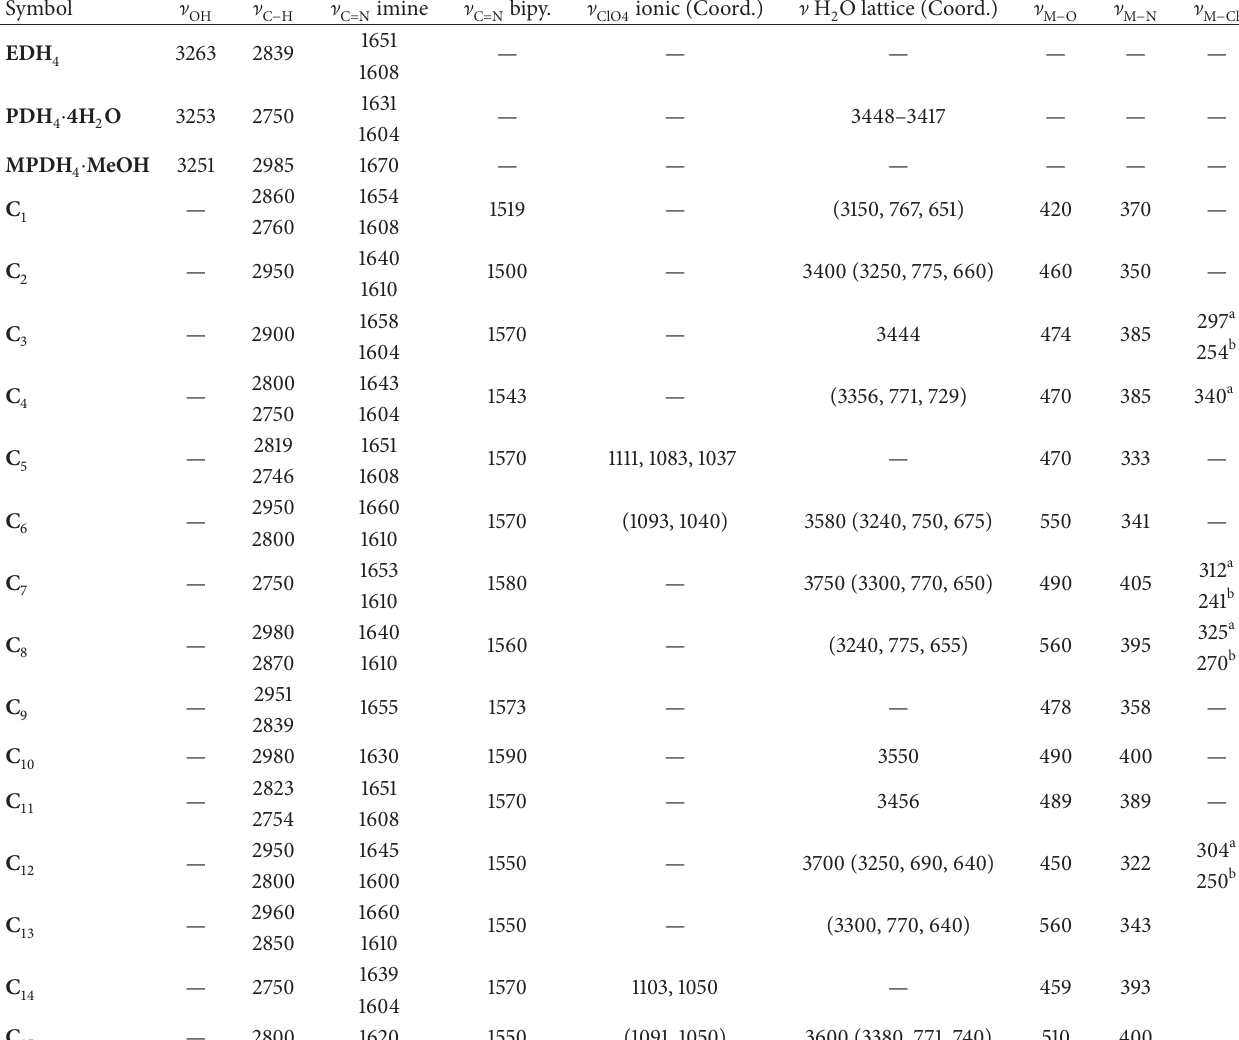
Table 2: Significant bands in the FTIR spectra (cm − 1 ) for Schiff bases and their metal complexes.